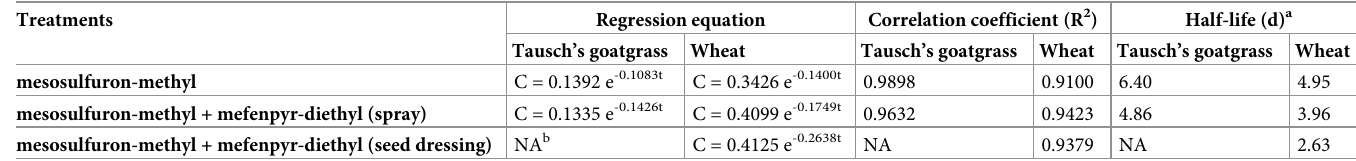
Table 3. Regression equation, correlation coefficient and half-life of mesosulfuron-methyl in Tausch’s goatgrass and wheat under different treatments.